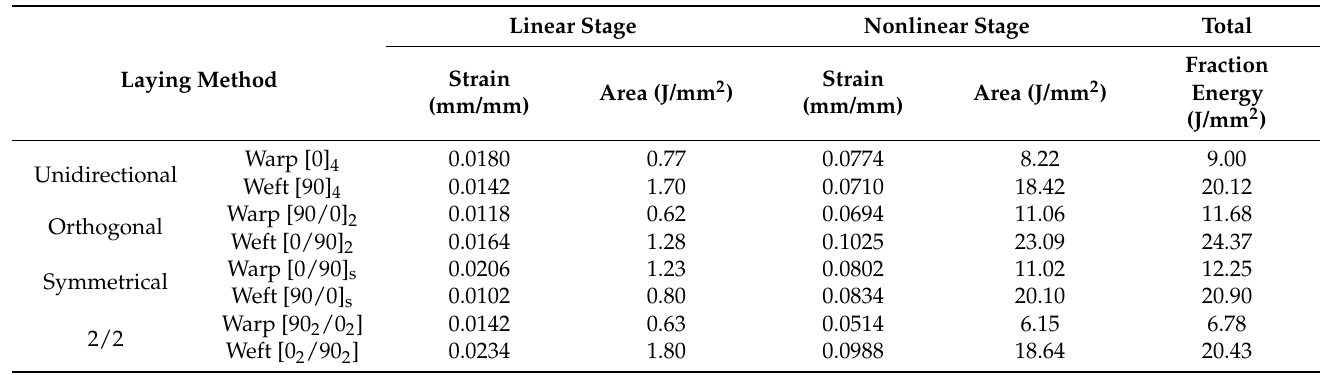
Table 5. Material fraction energy with various laying